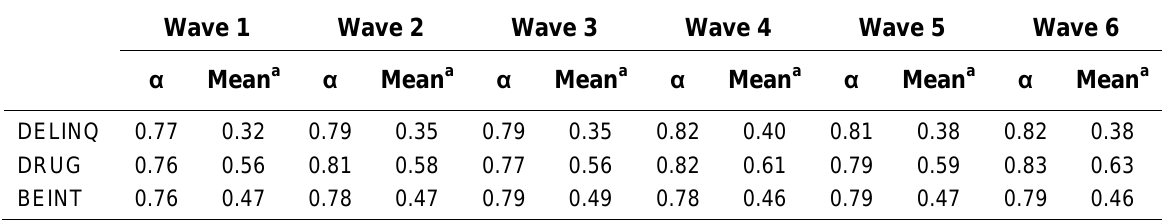
Internal Consistency and Mean Interitem Correlations for Composite Problem Behavior